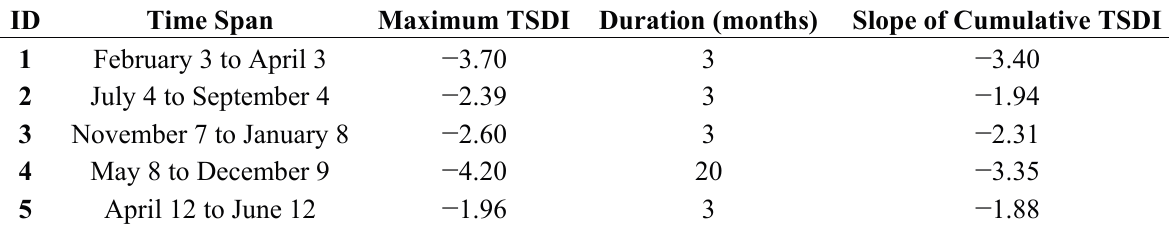
Table 4. Summary of GRACE TSDI-identified drought